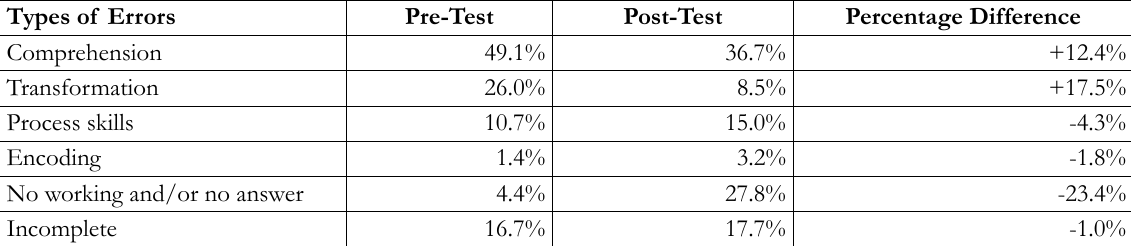
Table 2. Percentage means of types of error in the pre- and the